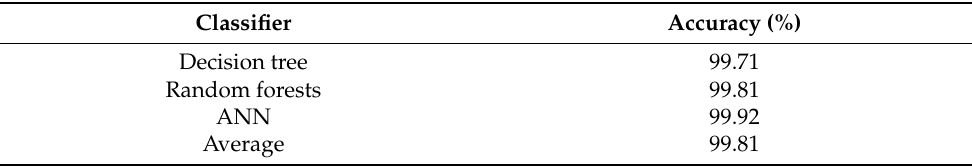
Table 12. Performance results of the classification